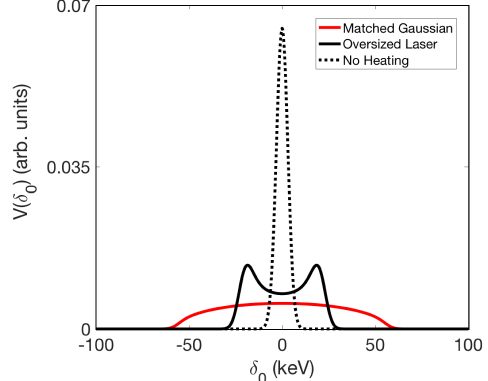
FIG. 2. Energy distributions due to a Gaussian laser profile. When the laser becomes oversized, the e-beam is split into two ð 0 Þ , the maximum energy modulation. The unheated groups at (cid:4) δ L matched Gaussian distribution is the theoretically predicted energy distribution of the e-beam after heating with the current LH.